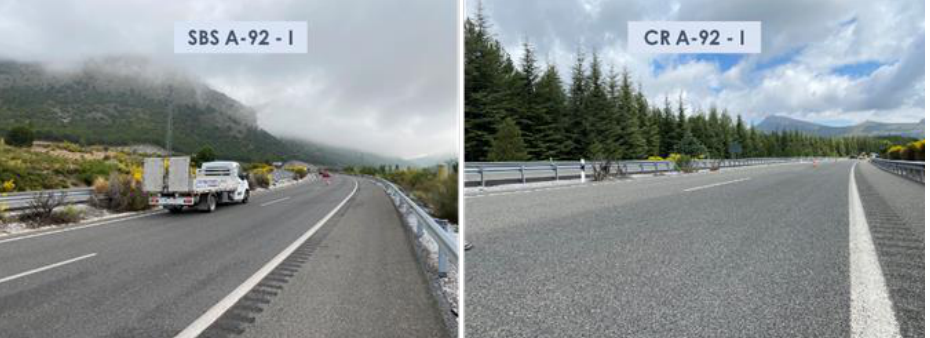
Figure 4. Aspects of the surface asphalt layers manufactured with SBS and crumb-rubber-modified binders on A-92 highway after 46 months of service life.